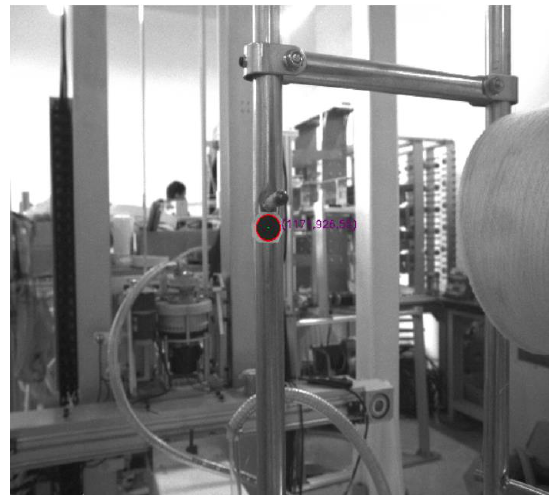
Figure 9. Effect drawing of creel positioning.